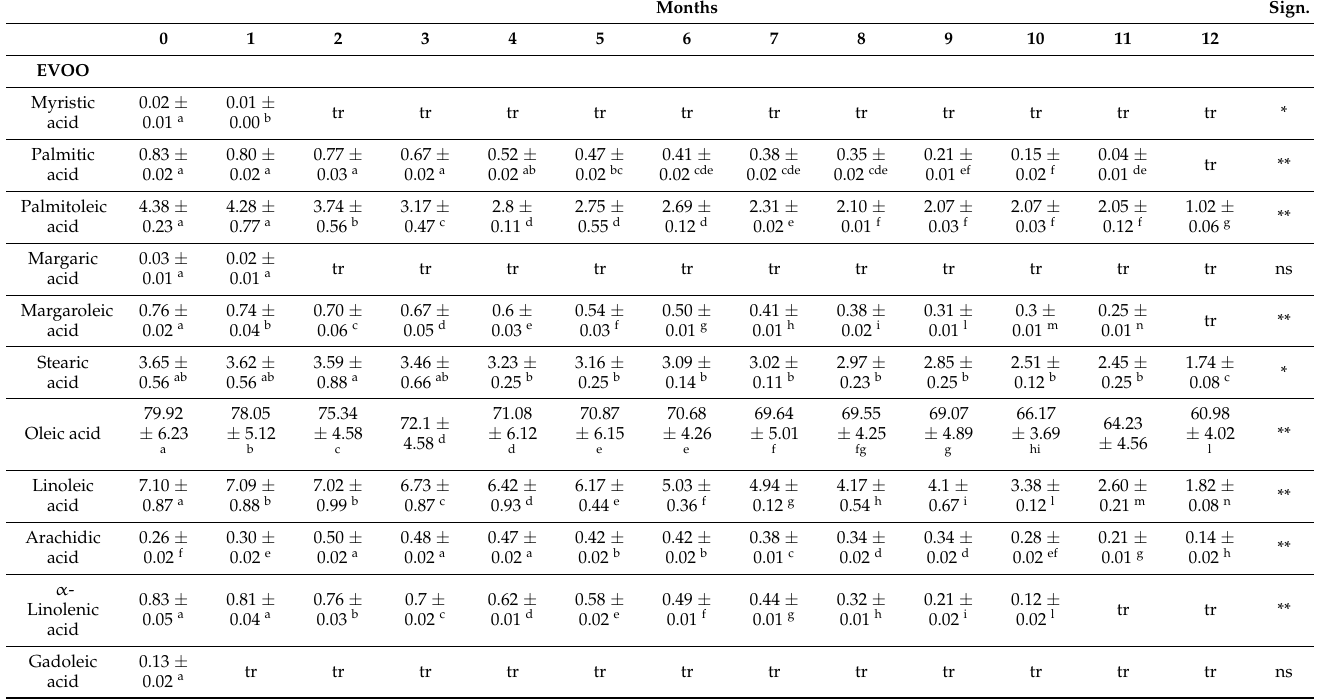
Table 8. Fatty acid profile of EVOO, EVOO_DTL, and EVOO_DTD samples (%). Months